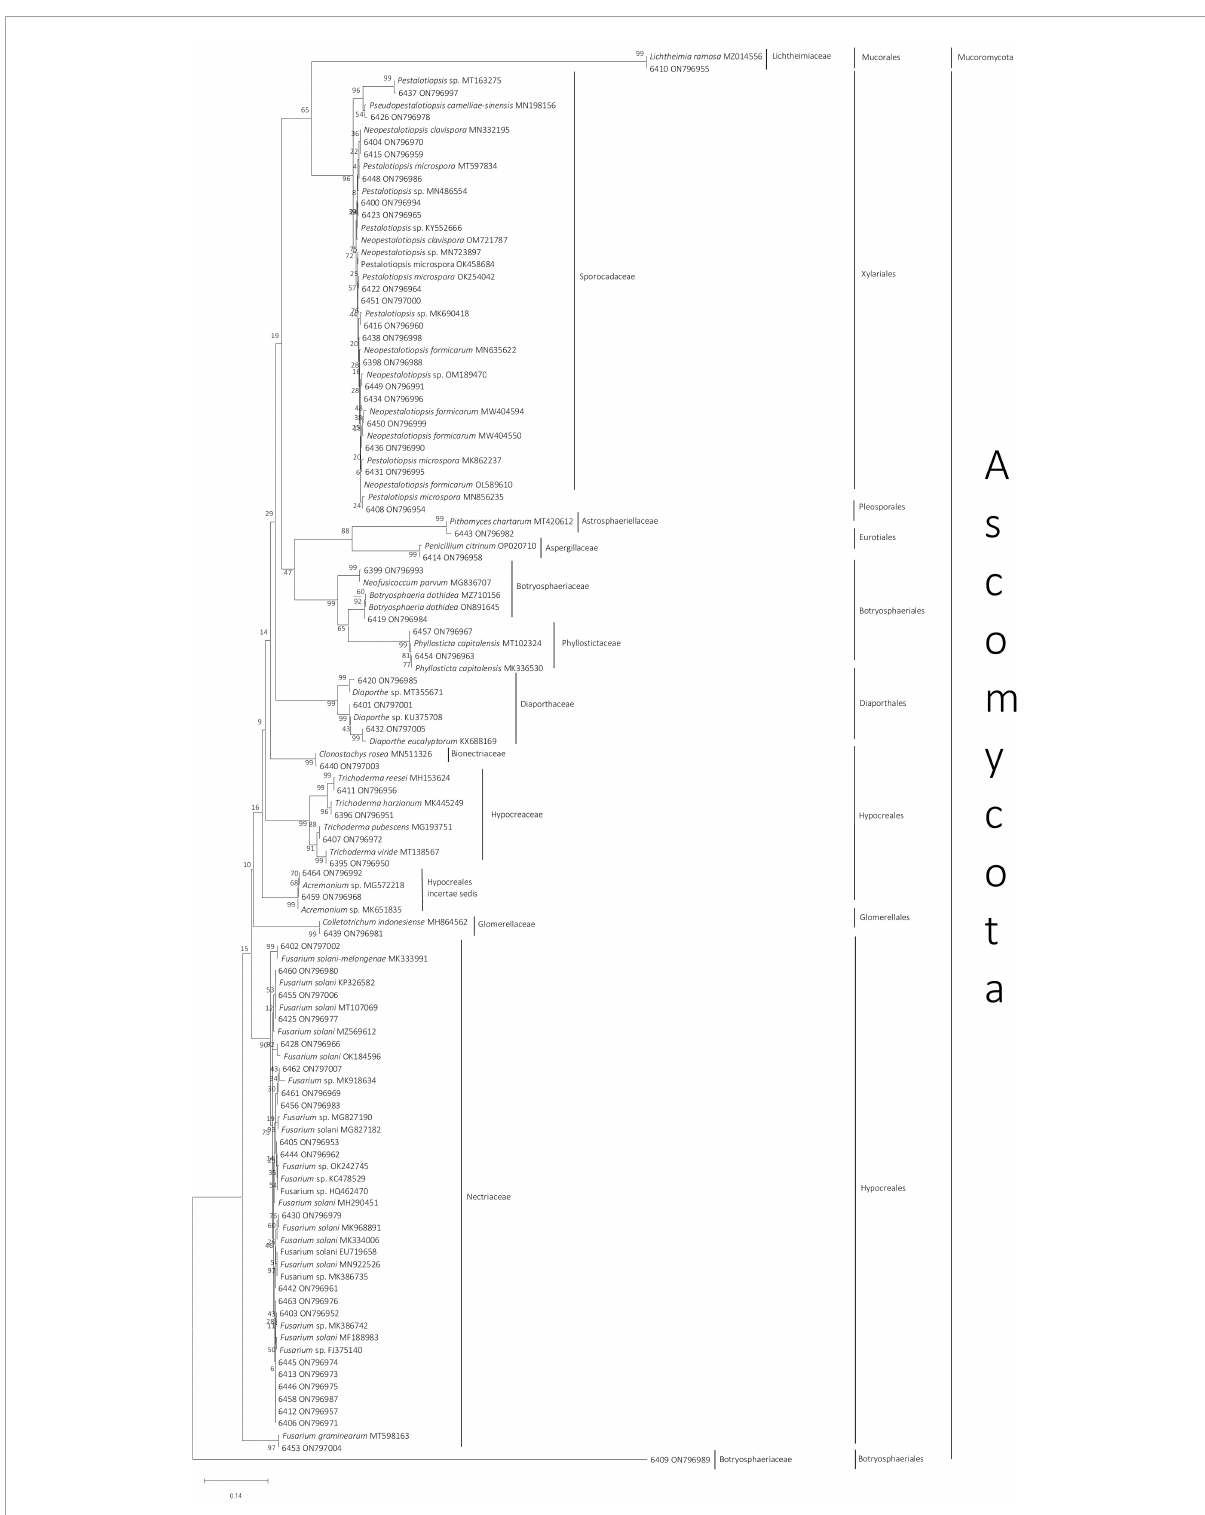
FIGURE1 Neighbor-joining phylogenetic tree of 58 endophytic fungi isolated from Styrax sumatrana and Styrax benzoin and their respective reference based on fungal internal transcribed spacer sequence. Fungi from this study are presented as their isolate number followed by their National Center for Biotechnology Information accession number, whereas for reference sequences, species name, and accession number are given ( Supplementary Table 1